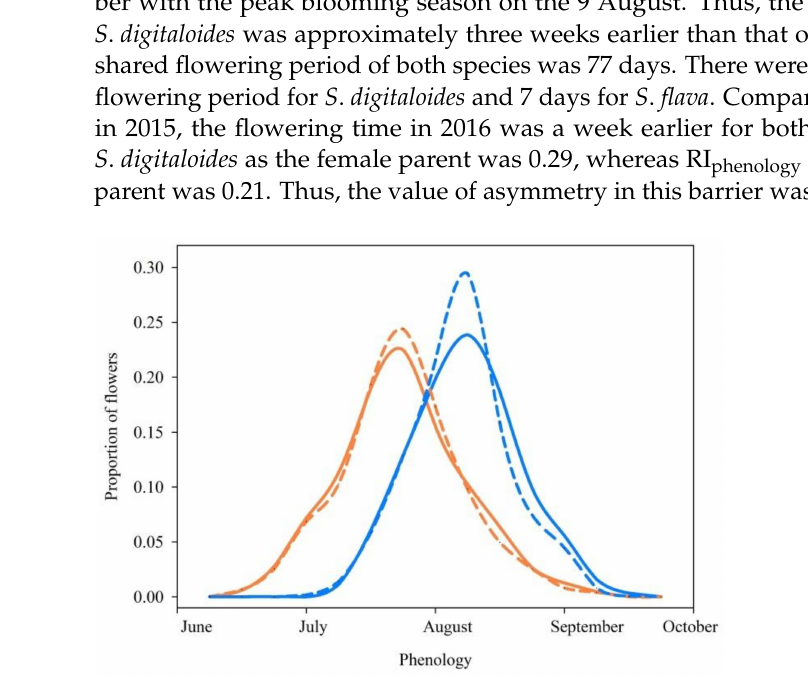
Figure 3. Flowering phenology of Salvia digitaloides (coral lines) and S . flava (blue lines). The solid and dashed lines denote the years of 2015 and 2016 for each Salvia